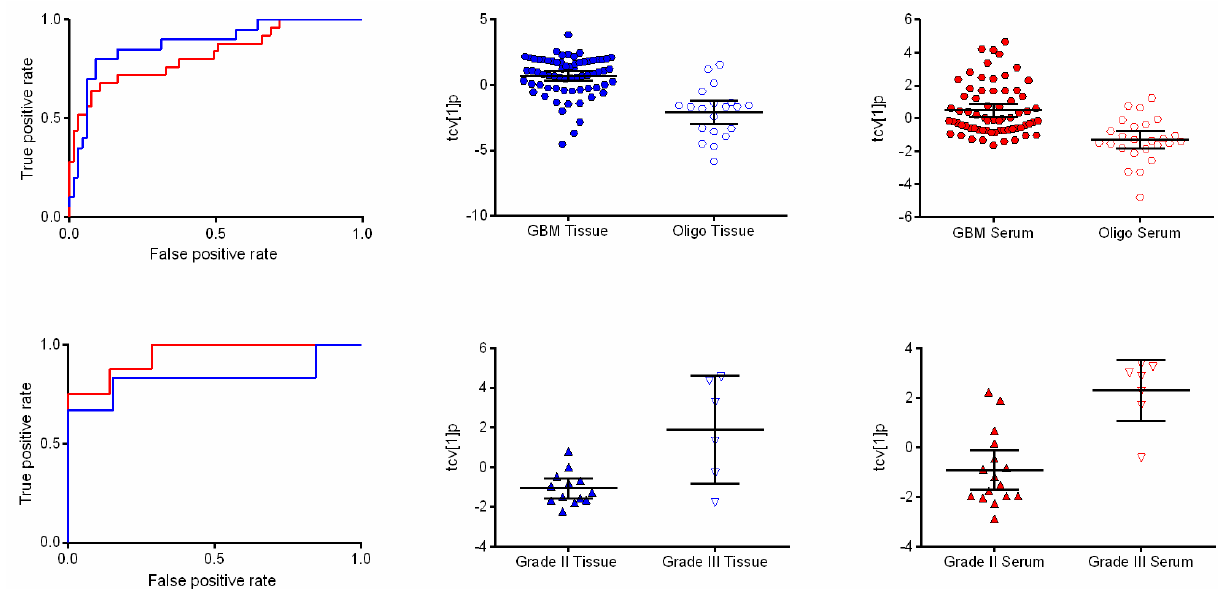
Figure 1. Receiver operating characteristic (ROC) curves and scatter plots of orthogonal partial least squares-discriminant analysis (OPLS-DA) scores following a seven-fold cross-validation procedure showing differences associated with diagnosis and tumor grade. ( Upper panel ) ROC curves based on the cross-validated score values from the final OPLS-DA model for the discrimination of glioblastoma and oligodendroglioma in tissue (blue line) and serum (red line) with area under the ROC curve (AUROCC) values of 0.881 (0.791–0.970) and 0.826 (0.722–0.929), respectively (left) . The scatter plots show the